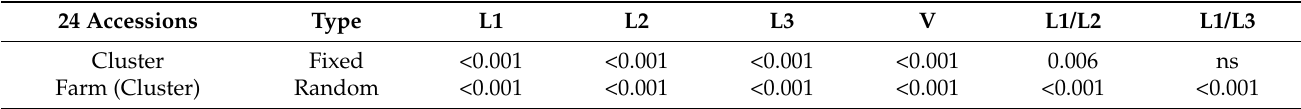
Table 3. Results of the ANOVA performed on morphometric data in the 24 Solina accessions.